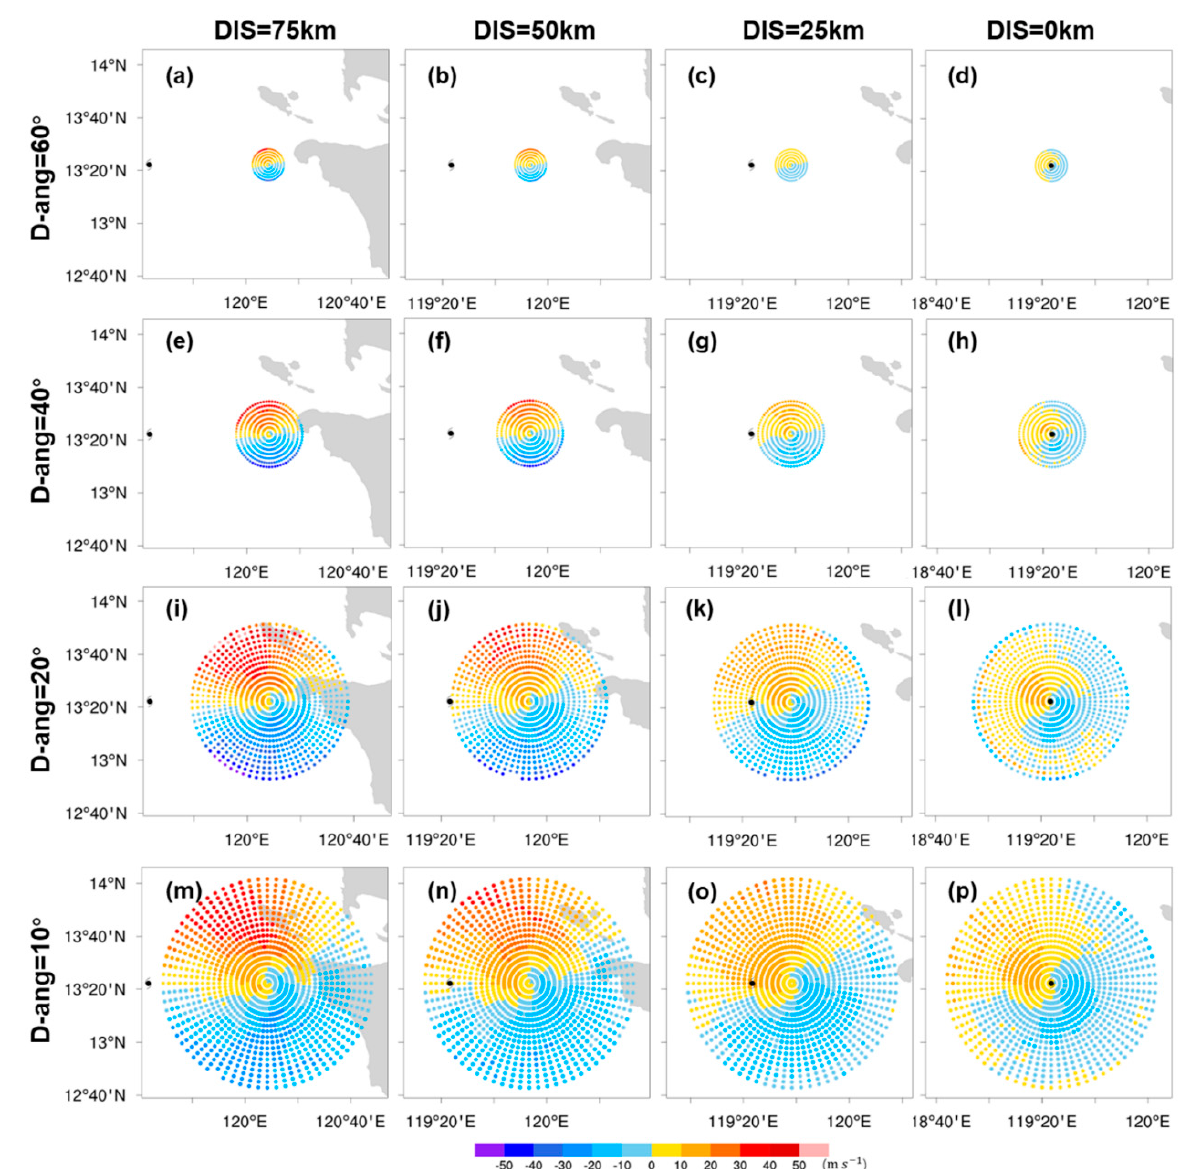
Figure 7. The simulated radar radial wind observations under different angles of depression (D-angs) and different distances from the airship to the TC center (DISs). ( a – d ) D-ang = 60°, ( e – h ) D-ang = 40°, ( i – l ) D-ang = 20°, ( m – p ) D-ang = 10°; ( a , e , i , m ) DIS = 75 km, ( b , f , j , n ) DIS = 50 km, ( c , j , k , o ) DIS = 25 km, ( d , h , l , p ) DIS = 0 km.